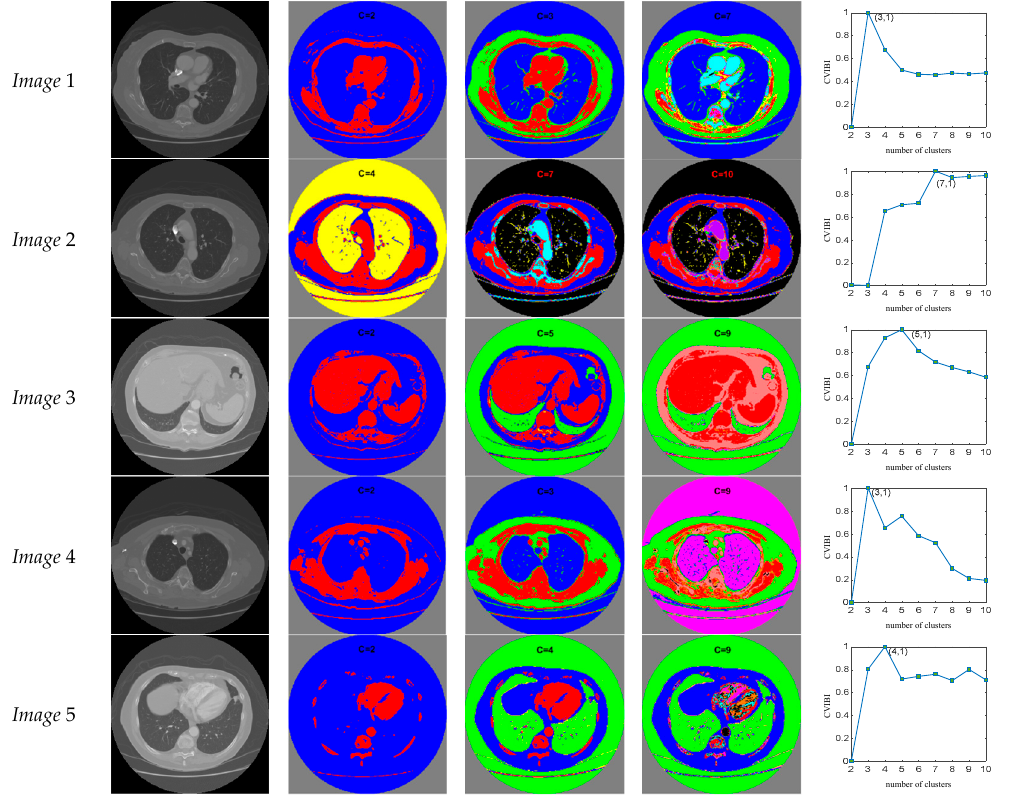
Figure 15. Tests of CVIBI on CT images with C-means.